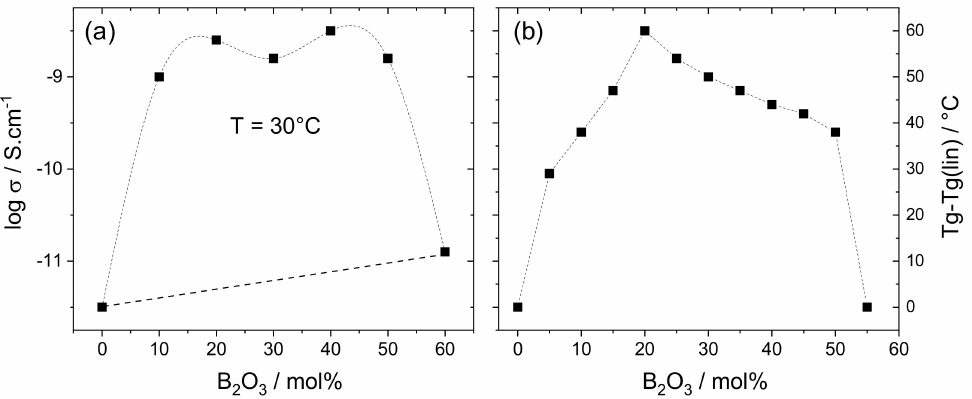
Figure 1. ( a ) Logarithm of conductivity ( σ ) in the 40Na 2 O-xB 2 O 3 -(60-x)P 2 O 5 glass system with the values expected from a linear evolution (dotted lines) ([18]); ( b ) Tg-Tg(lin) evolution in